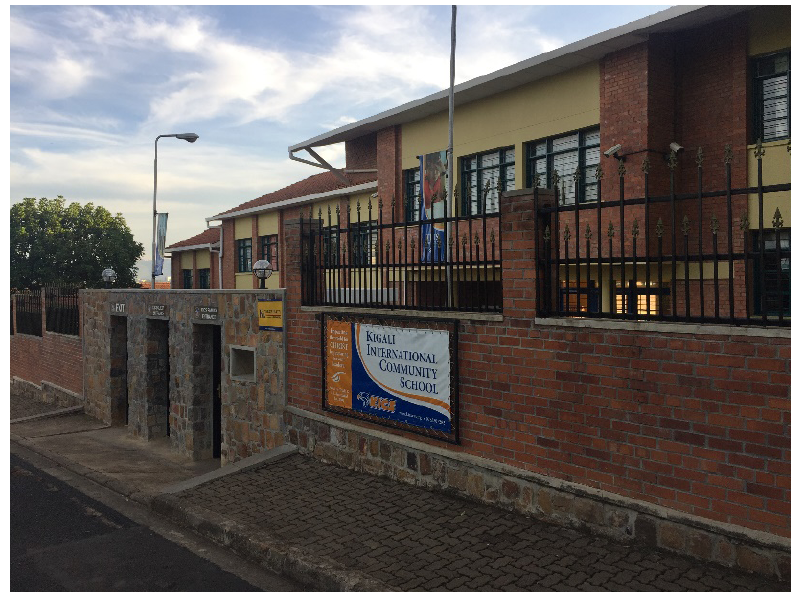
Figure 30. The Kigali 2020 International School. Photograph by Manlio